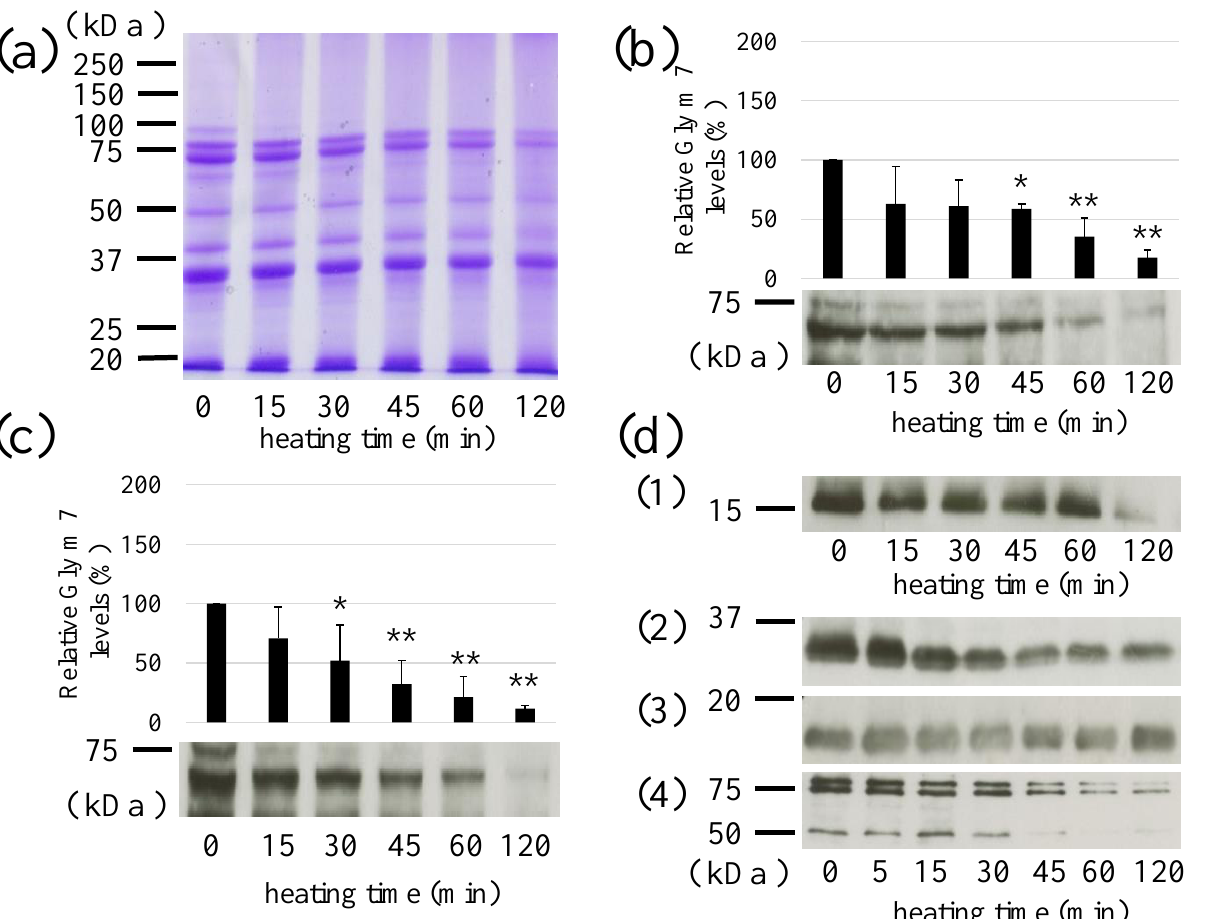
Figure 6. Heat stability of Gly m 7 and other soybean allergens. Soybean extracts were heated for the indicated time and subsequently subjected to sodium dodecyl sulphate–polyacrylamide gel electrophoresis. ( a ) Coomassie Brilliant Blue staining of heated soybeans ( b ) Gly m 7 levels detected using anti-Gly m 7 antibodies ( c ) Gly m 7 levels detected using horseradish peroxidase-labeled streptavidin. The relative intensity at Time Point 0 was set at 100 %. Signal intensities were measured as described in the Materials and Methods section. Experiments were performed three times, and the data are presented graphically, with bars representing means and error bars representing the SD. *: p < 0.05, **: p < 0.01. ( d ) Time-dependent changes of other soybean allergens. ( 1 ) Gly m 4, ( 2 ) Gly m Bd 30K, ( 3 ) Gly m 6 (basic subunit), ( 4 ) Gly m 5.